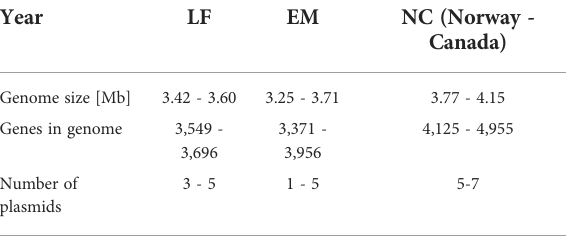
TABLE 2 Genetic characteristics of the 3 known genogroups of P. salmonis . Adapted from Schober (78). Year LF